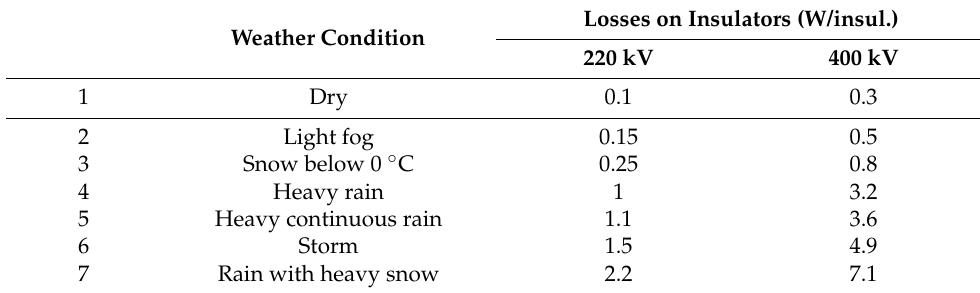
Table 2. Leakage losses due the different weather conditions (adopted from [13], 2017, Int. J. Eng. Sci. ). Losses on Insulators Weather Condition